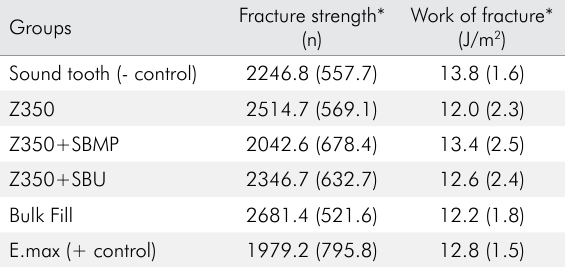
Table 2. Mean and standard deviation (SD) values for the fracture strength and work of fracture of groups investigated.